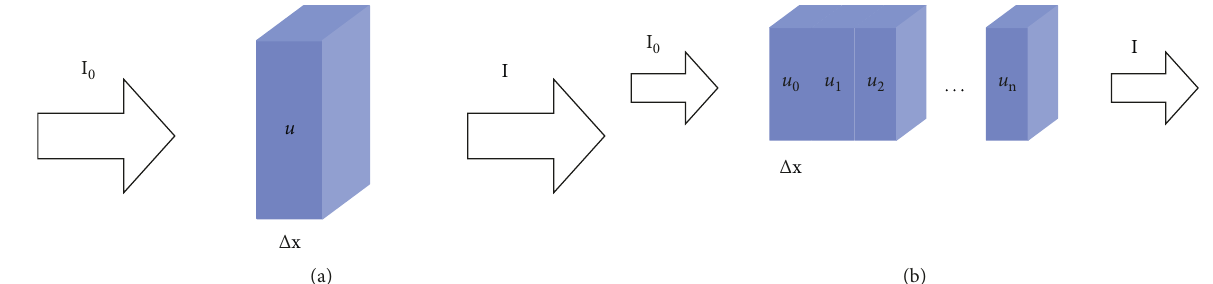
Figure 2: Schematic diagram of visual light passing through. (a) Schematic diagram of robot vision light passing through homogeneous material. (b) Schematic diagram of the robot’s vision of light passing through inhomogeneous